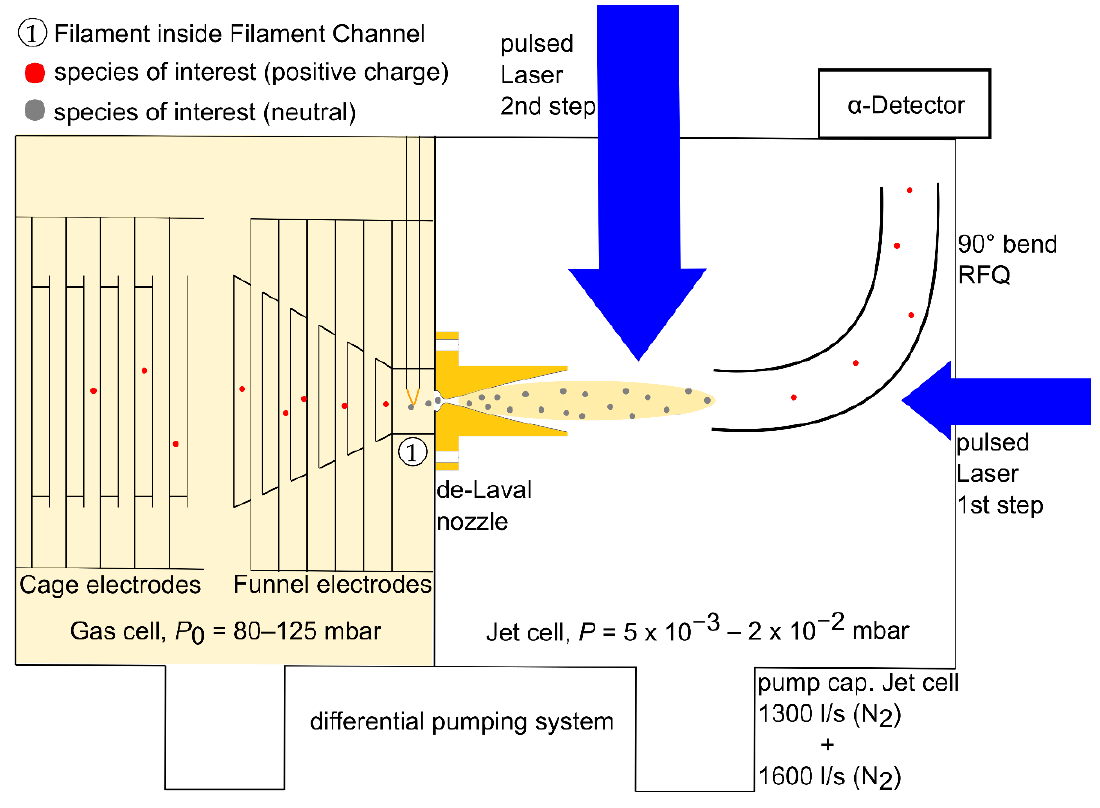
Figure 1. Schematic overview of JetRIS. On the left side are the cage and funnel electrodes. In front of the nozzle, there is a tantalum filament. After being evaporated from the filament, the atoms follow the flow of the buffer gas through the nozzle into the gas-jet. Here, two laser beams used in a cross-beam geometry resonantly ionizes the formerly neutralized species of interest. The ions are guided around a curve via a 90° bend RFQ and collected on an α -Detector.